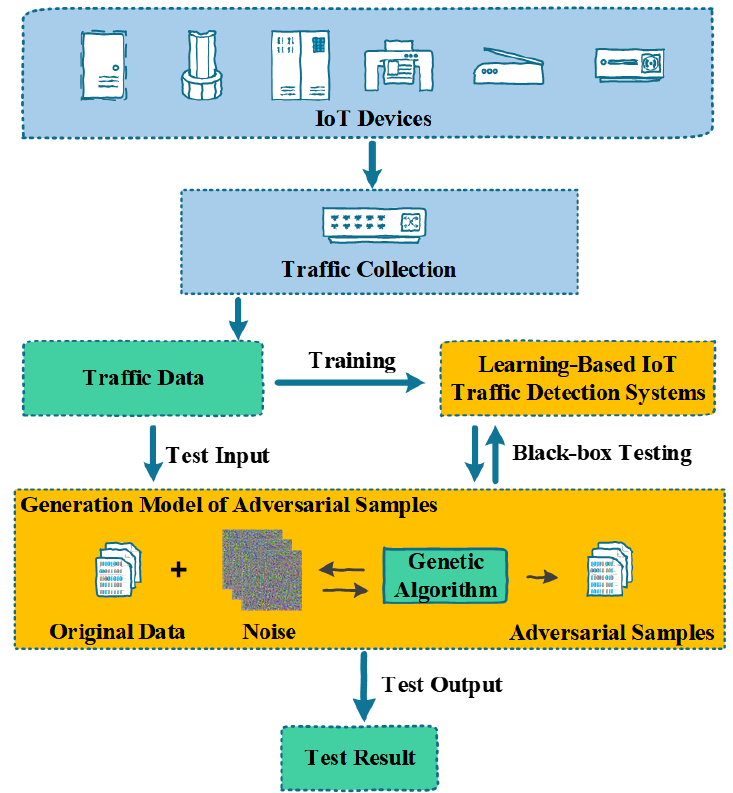
Figure 1. Overview of our testing framework for learning-based IoT traffic detection